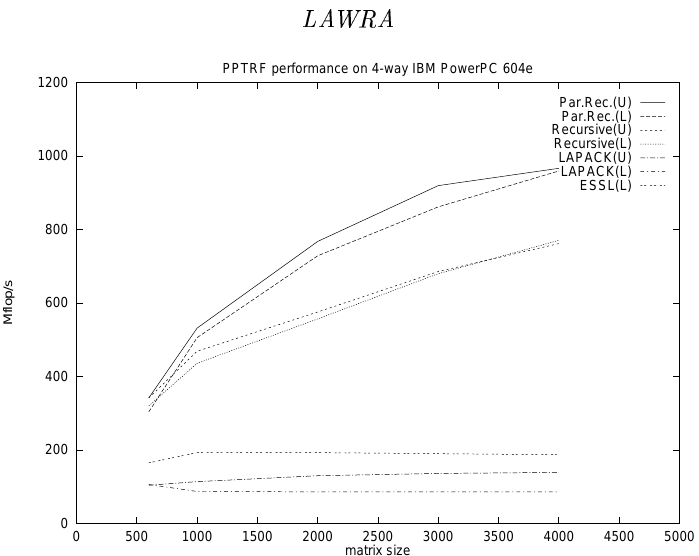
Figure4.Theperformancegraphsbetweendi(cid:11)erentpackedstoragedataformatsofthe